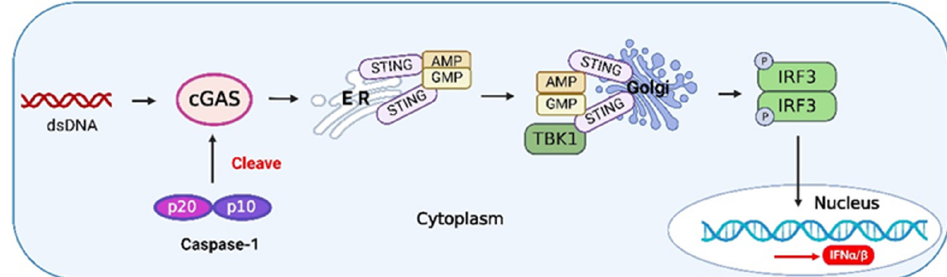
Figure 5. The crosstalk between caspase-1 and type I IFNs. Upon binding to DNA, cyclic GMP-AMP synthase (cGAS) undergoes a conformational change to generate an active state and produces the second messenger cyclic GMP-AMP (cGAMP) from adenosine triphosphate (ATP) and guanosine triphosphate (GTP), which is subsequently detected by the cyclic-dinucleotide sensor (CDNS), stim- ulator of interferon genes (STING), a transmembrane protein located in the endoplasmic reticulum (ER). Binding of cGAMP induces the activation of STING, and the activated STING is translocated to the Golgi and activates tumor necrosis factor (TNF) receptor-associated factor (TRAF) family member-associated NF- κ B activator (TANK)-binding kinase 1 (TBK1). TBK1 phosphorylates IRF3 and induces its dimerization. The dimerized IRF3 enters the nucleus and triggers the production of type I IFNs [125]. Activated caspase-1 during inflammasome activation can cleave cGAS, inhibit- ing the IFN pathway induced by DNA viruses. The figure was created using the online software “Biorender” (https://app.biorender.com/ The updated figure was created on 30 November